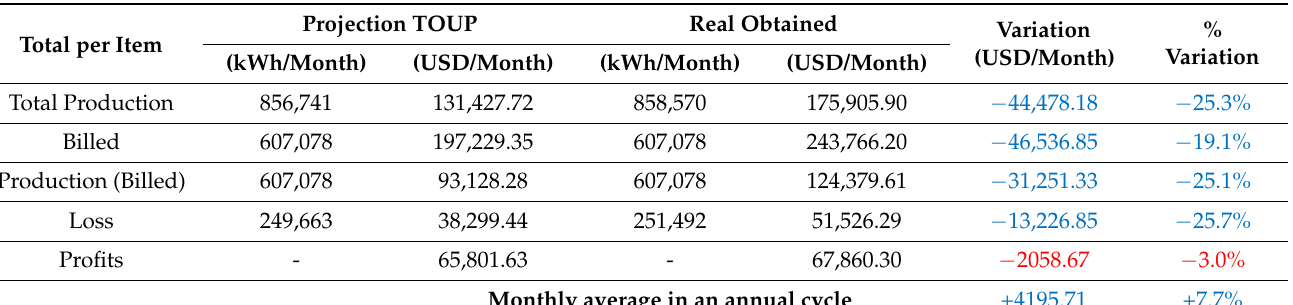
Variation in tendencies of February 2020 with moving commercial customers of ≤ 240 (kWh/month).